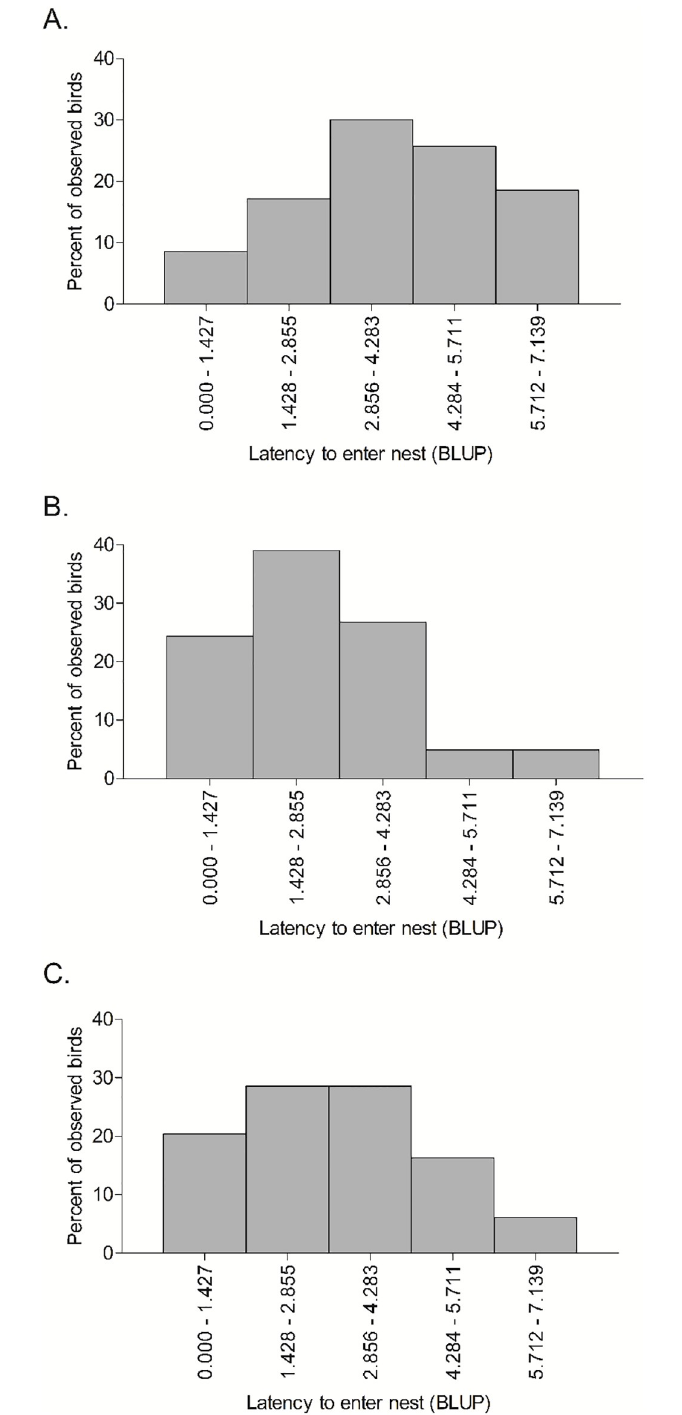
Fig 3. The distribution of individual relative scores (calculated as BLUPS) of latency to enter nest at three colony sites observed during 2017 and 2018 (years pooled at each site). Total number of birds at each colony site was 70 for (A) McDougals, 41 for (B) CR-1, and 49 for (C) Junkyard. Lower bin ranges represent shorter Latency to enter nest times.